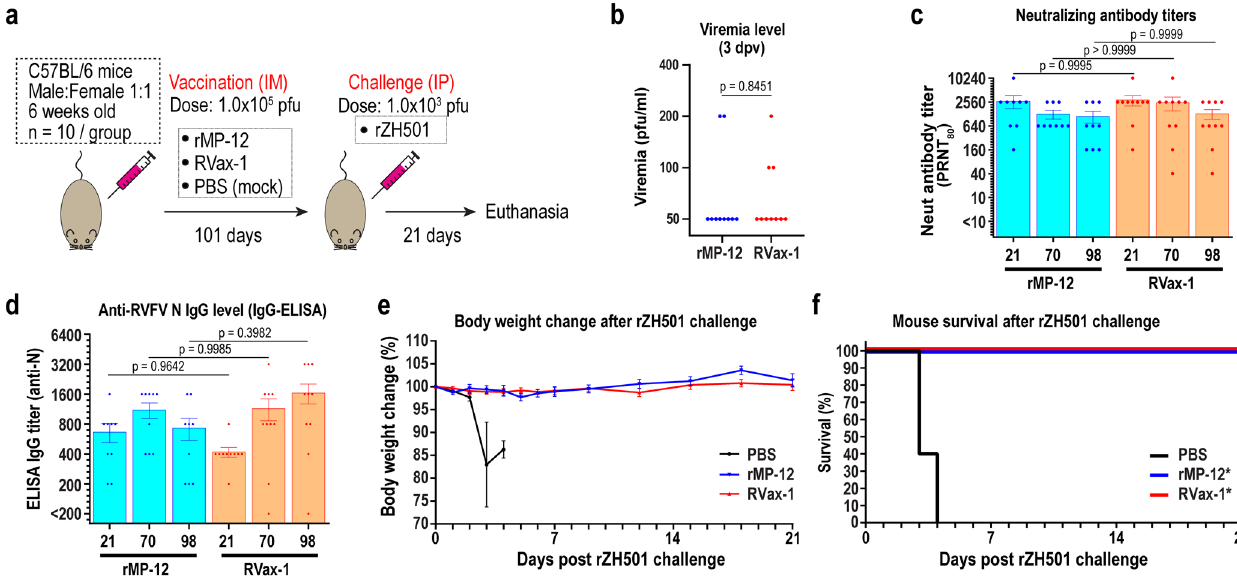
Fig. 4 Immunogenicity and protective ef fi cacy of rMP-12 and RVax-1 in C57BL/6 mice. a Schematic representation of vaccination and challenge experiment. C57BL/6 mice were IM mock-vaccinated or vaccinated with 1 × 10 5 PFU of rMP-12 or RVax-1 ( n = 10 per group), followed by rZH501 challenge at 101 dpv. One rMP-12-vaccinated animal died accidentally at 21 dpv during anesthesia. b Serum virus titers (PFU/ml) at 3 dpv are shown. Two vaccine groups were compared by unpaired t -test ( t = 0.1982, df = 18). c Plaque Reduction Neutralizing Test 80 (PRNT 80 ) neutralizing antibody titers at 21, 70, or 98 dpv are shown in a scattered dot plot graph with the means ± standard errors. Means were compared by one-way ANOVA followed by Tukey ’ s multiple comparison test ( F = 1.149, df = 5). d ELISA IgG titers at 21, 70, and 98 dpv, and 21 dpc are shown in a scattered dot plot graph with the means ± standard errors. Means were compared by one-way ANOVA followed by Tukey ’ s multiple comparison test ( F = 2.186, df = 5). e Body weight changes after rZH501 challenge (means ± standard errors) are shown. f The graph represents Kaplan – Meier survival curves after rZH501 challenge. Asterisks represent statistically signi fi cant differences ( p < 0.01) based on log-rank testing compared to the mock-vaccinated repeated mouse experiment (Fig. 5). Mock-vaccinated mice showed high levels of alanine aminotransferase (ALT) (beyond measurable range, >5400% vs. normal), alkaline phosphatase (ALP) (mean 190% vs. normal), total bilirubin (mean 569% vs. normal), creatinine (mean 313% vs. normal), and blood urea nitrogen (143% vs. normal), whereas the glucose level was reduced (mean 34% vs. normal) (Fig. 6f). Mice vaccinated with either rMP-12 or RVax-1 showed normal values for those markers at 3 dpc.